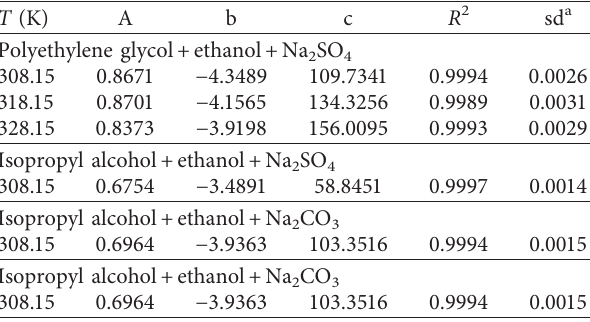
is the experimental mass fraction of the alcohol mixture, w cal i is the corresponding data calculated using equation (5), and “ N ” represents the number of binodal data